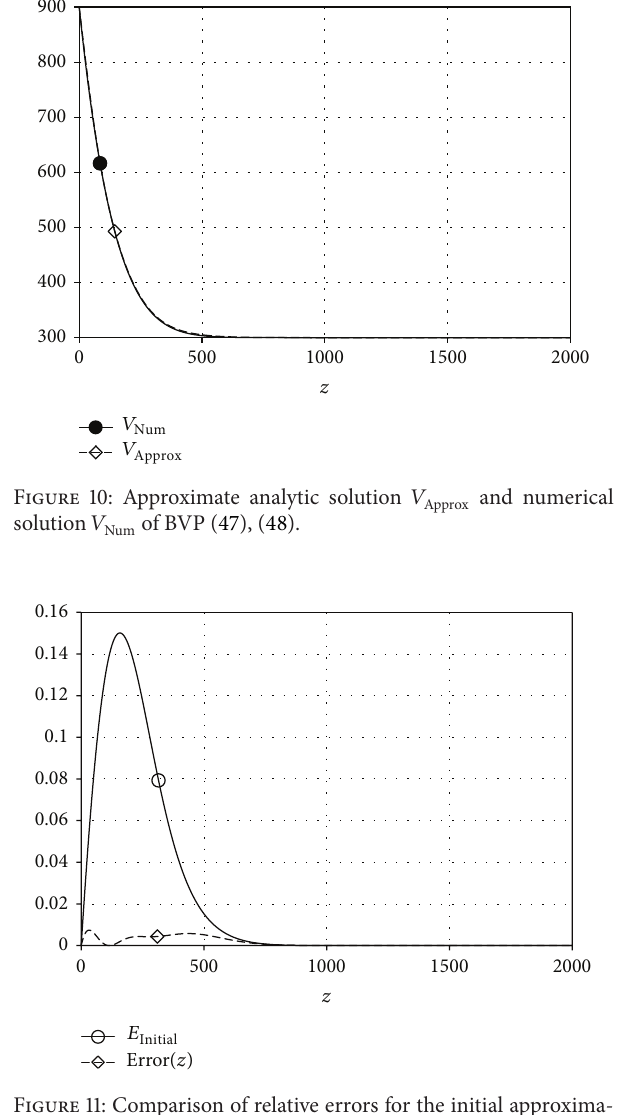
Figure 11: Comparison of relative errors for the initial approxima- tion and approximate analytic solution of BVP (47), (48).